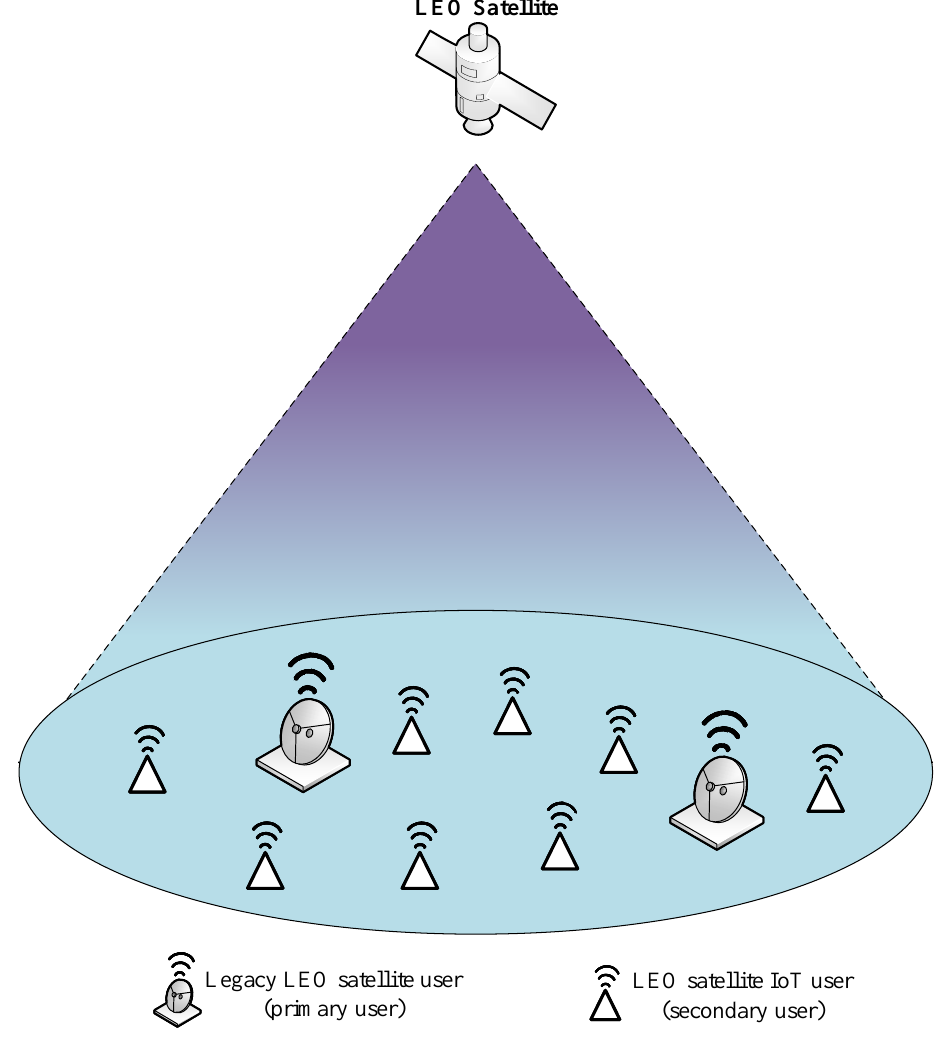
Figure 1. Cognitive LEO Satellite Communication